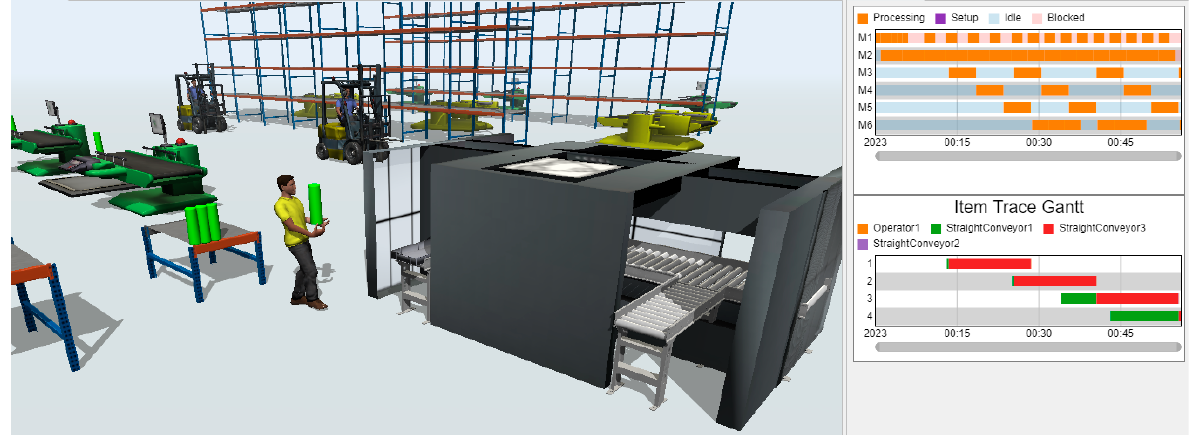
Figure 5. Digital twin model in FlexSim.